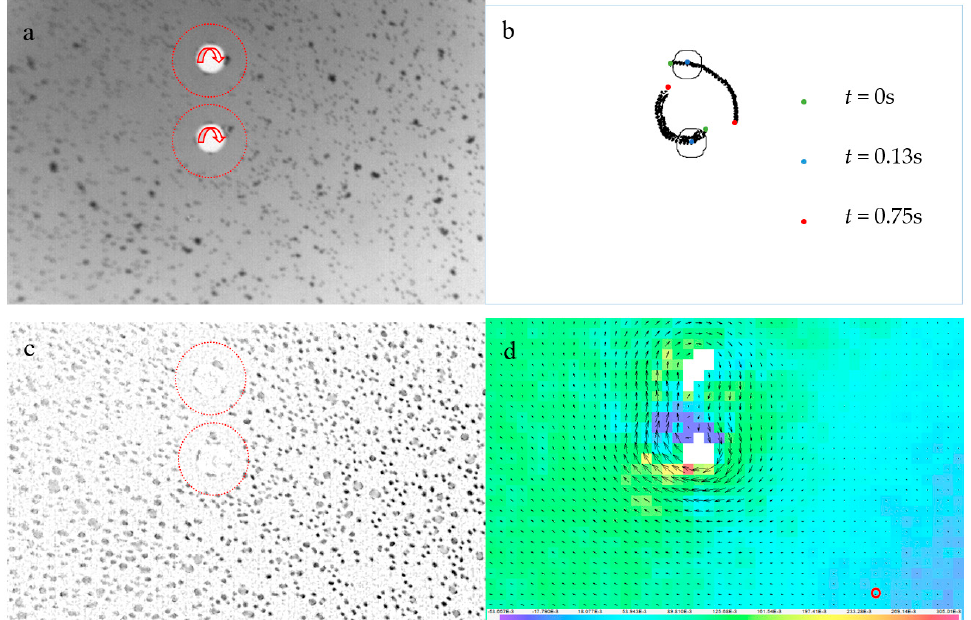
Figure 17. ( a ) Inverted raw particle image of 100 µm-diameter spinning micro-rafts at t = 0.13 s. Red arrows indicate rotation direction; red dashed circles show boundary for low seeding concentration. ( b ) The position of micro-rafts during the experiment. ( c ) Processed particle image after dynamic masking and local contrast normalization at t = 0.13 s ( d ) 2D3CµPIV results at t = 0.13 s, where colors indicate out of plane velocity. Red circle is where the time series is extracted in Figure 18a.